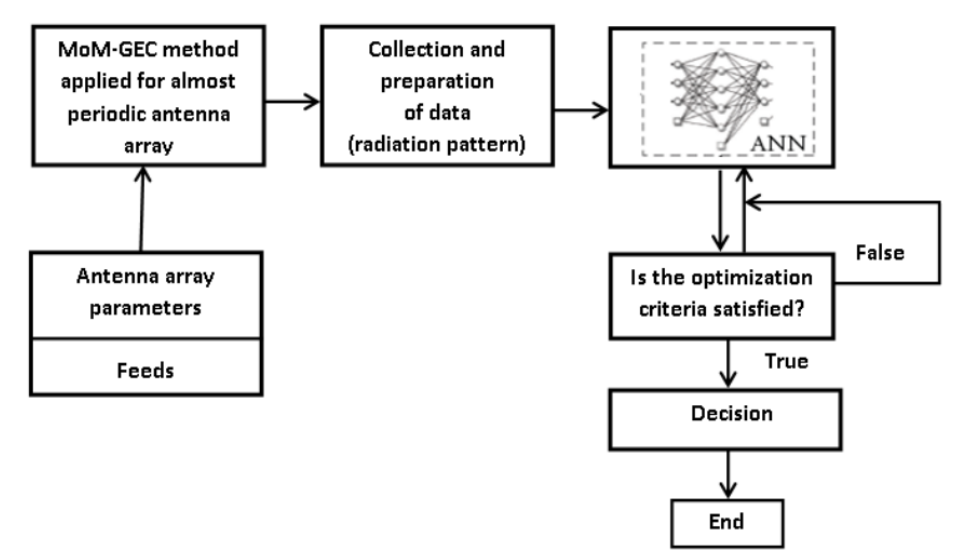
Figure 27. Flow diagram illustrating the numerical radiation pattern optimization using an artificial neural network